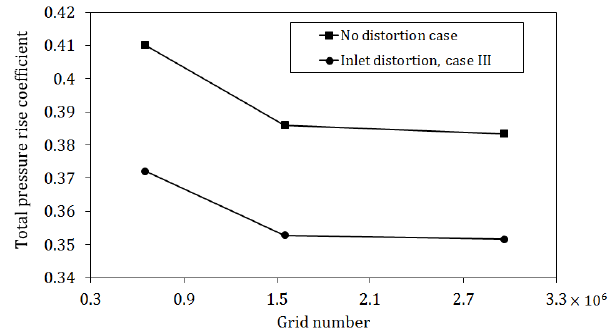
Figure 2. Undistorted inlet (case I) and distortion screens (cases II– VI).